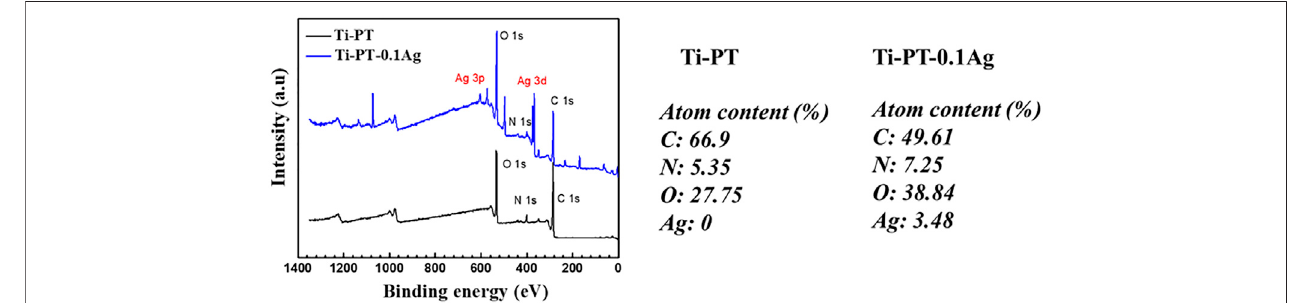
FIGURE 4 | XPS spectra survey for Ti-PT and Ti-PT-0.1Ag surfaces with the surface elemental composition.